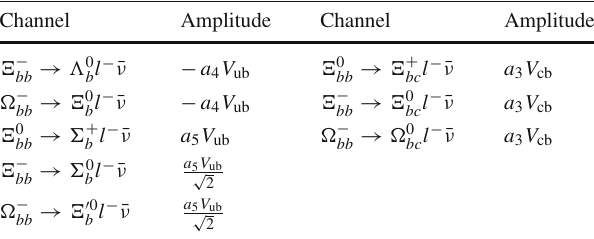
In this equation, we have included both charm quark and bot-